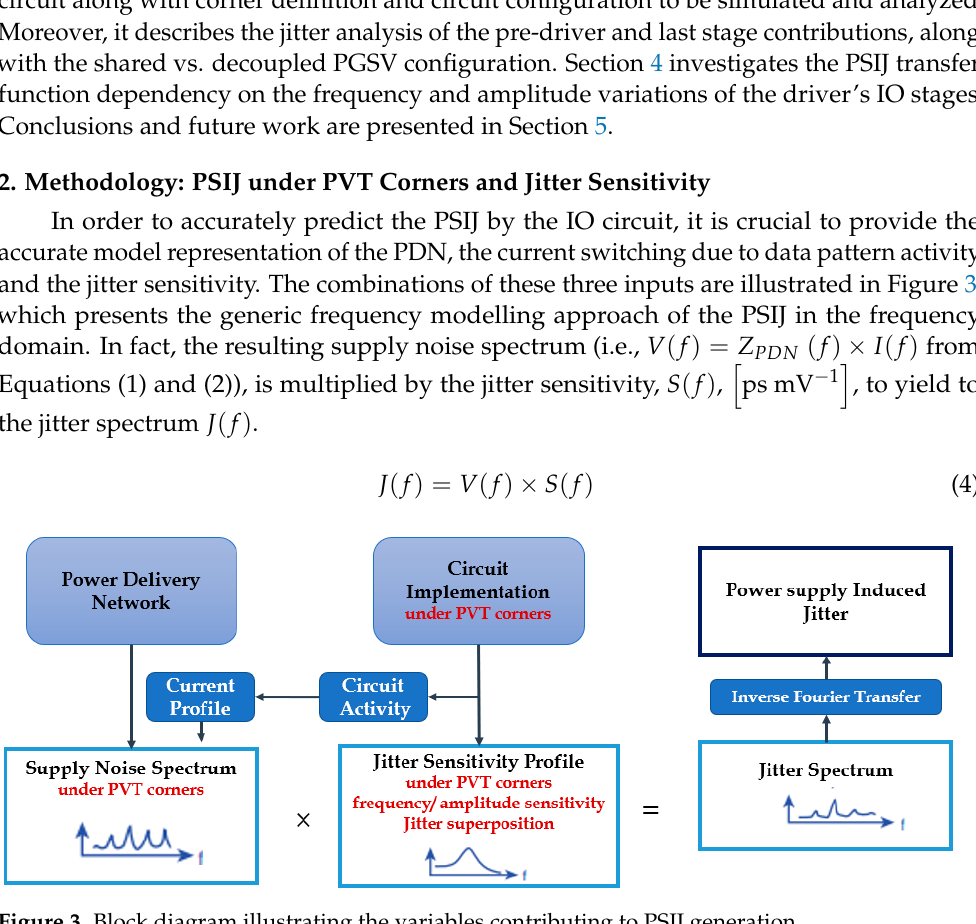
Figure 3. Block diagram illustrating the variables contributing to PSIJ generation.